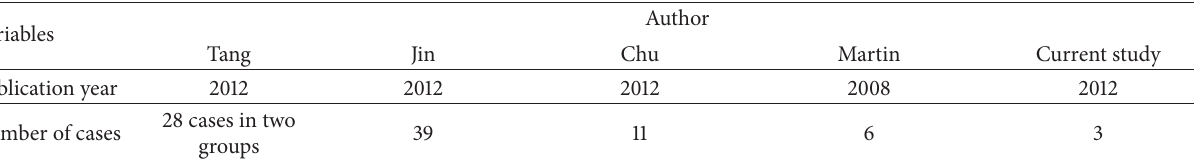
Table 4: Comparison of similar